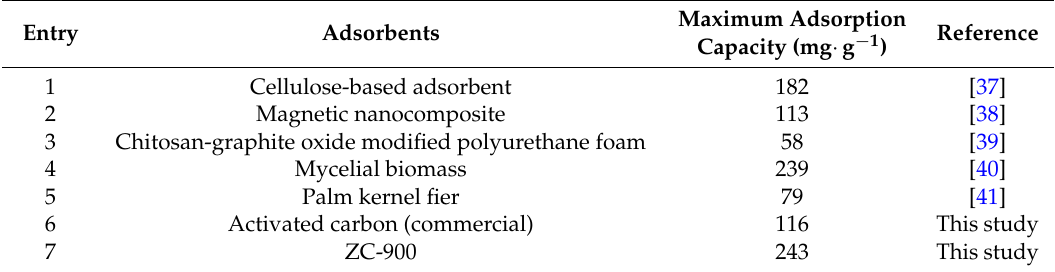
Table 3. Maximum adsorption capacities and Langmuir parameters for the adsorption of SA on different adsorbents.